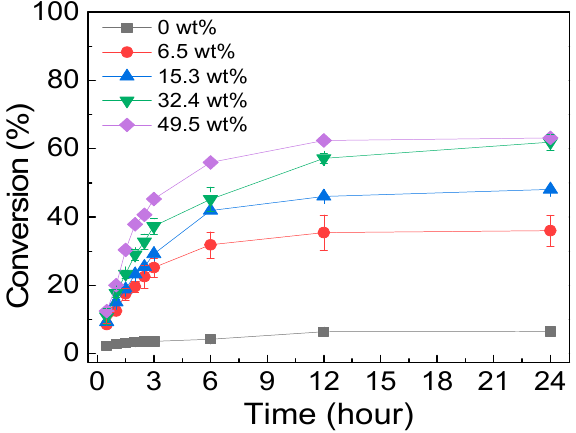
Figure 7. Methyl paraoxone (MPO) decomposition values of UiO-66 / DSPD composite films with different UiO-66 contents.